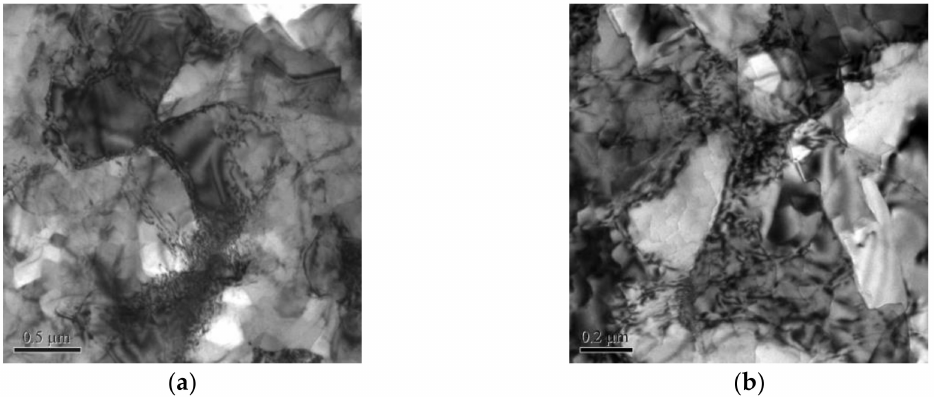
Figure 5. TEM images of alloy N1 at 85% cold rolling reduction. ( a ) with 5000 times magnification and ( b ) with 9900 times